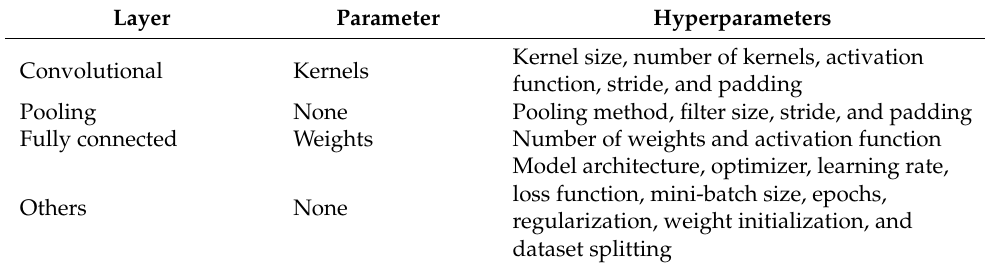
Table 1. List of parameters and hyperparameters in a CNN. (Data from Rikiya Yamashita et al. [90], Insights into Imaging, published by Springer Nature, 2018). Layer Parameter Hyperparameters Kernel size, number of kernels, activation Convolutional Kernels function, stride, and padding Pooling None Pooling method, filter size, stride, and padding Fully connected Weights Number of weights and activation function Model architecture, optimizer, learning rate, loss function, mini-batch size, epochs, Others None regularization, weight initialization, and dataset